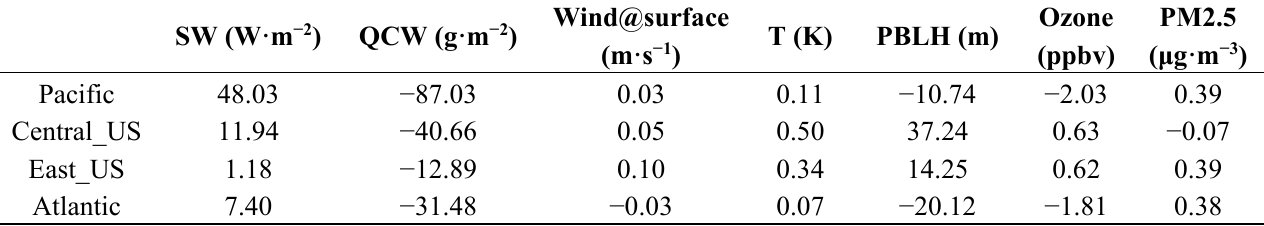
Table 4. Overall ACR effects on selected meteorological parameters and surface concentrations of ozone and PM2.5 for selected regions *.